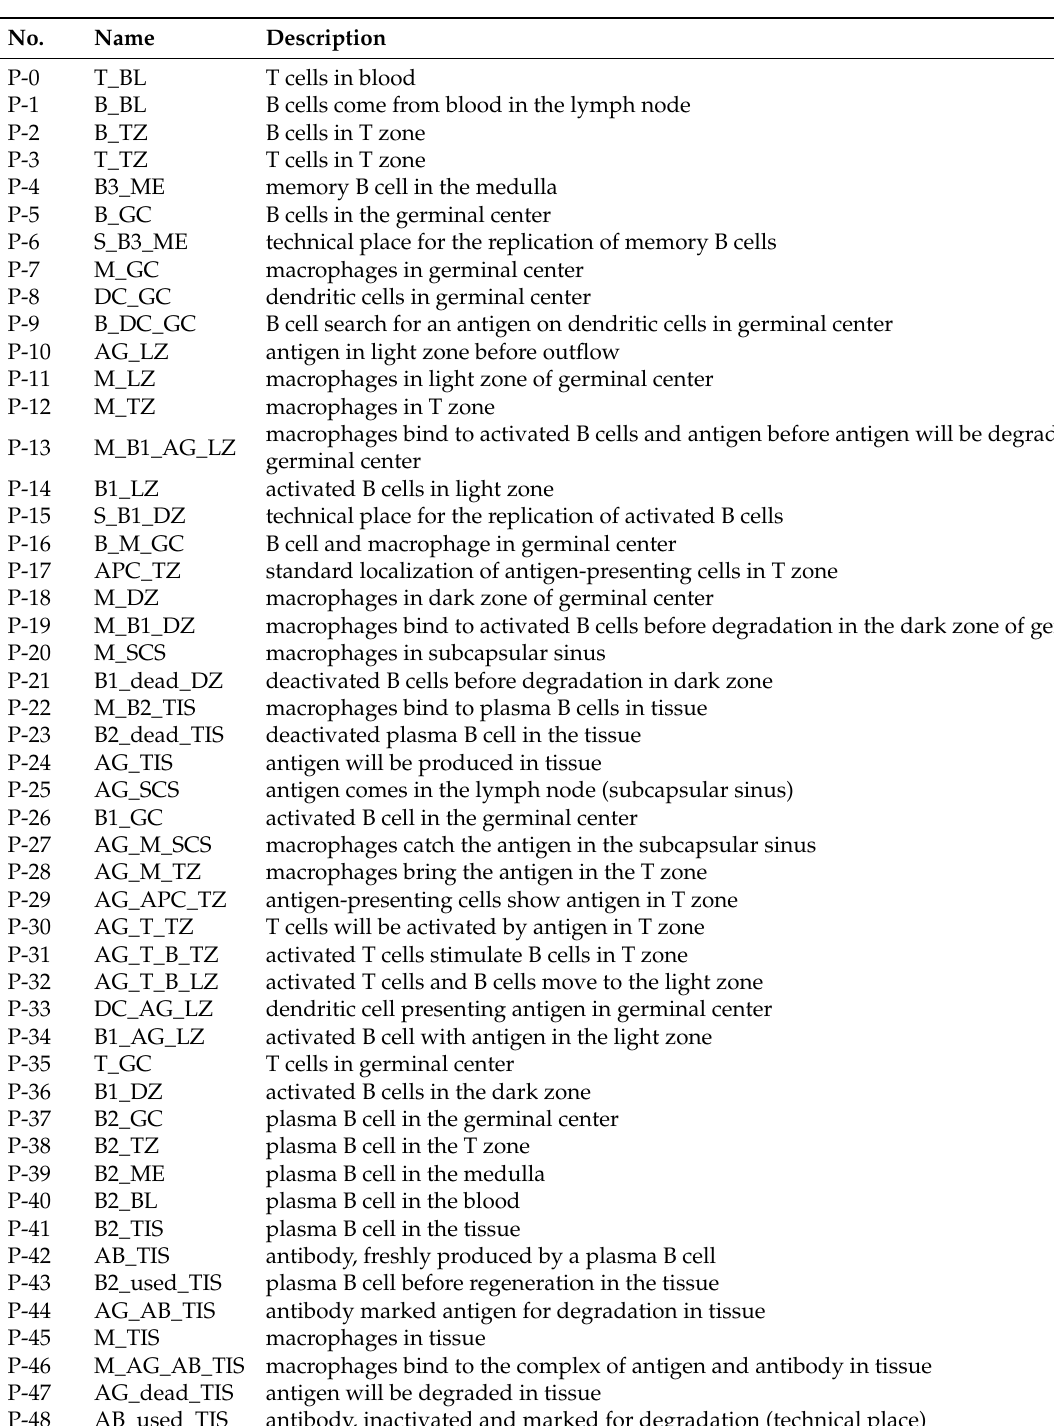
Table A1. The 49 places, their names, and a description of their biological meaning. The prefix of the name encodes the species, e.g., a cell, a set of interacting cells, or an antigen. The prefix is either a single abbreviation or a concatenation of abbreviations; for the abbreviations of types of species, refer to Table 2. The suffix of the name encodes the compartment in which the species is located; for the abbreviations of the compartments, refer to Table